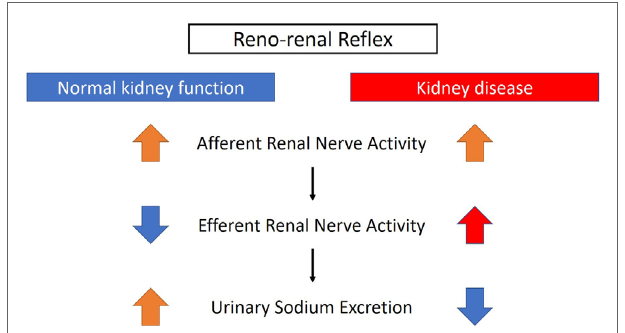
FigURe 3 | Different effects of renorenal reflexes with normal or impaired kidney function. With normal kidney function, the renorenal reflex operates as an inhibitory response, in which activation of renal sensory nerves by stimuli, including increased renal pelvic pressure, renal venous pressure, and renal pelvic administration of substance P, bradykinin, or capsaicin, decreases efferent renal sympathetic nerve activity that in turn increases urinary sodium excretion. When renal function is impaired, for example, with ischemic kidneys, the inhibitory reflex is attenuated and activation of afferent renal nerves results in a sympathoexcitatory